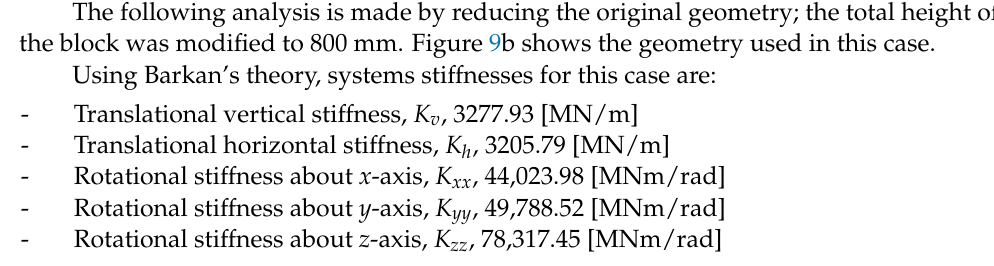
Table 3. Comparison between Barkan’s theory and FEM results in the intermediate case. Translation in x Translation in y Translation in z Direction Freq. Direction Freq. Direction Freq.